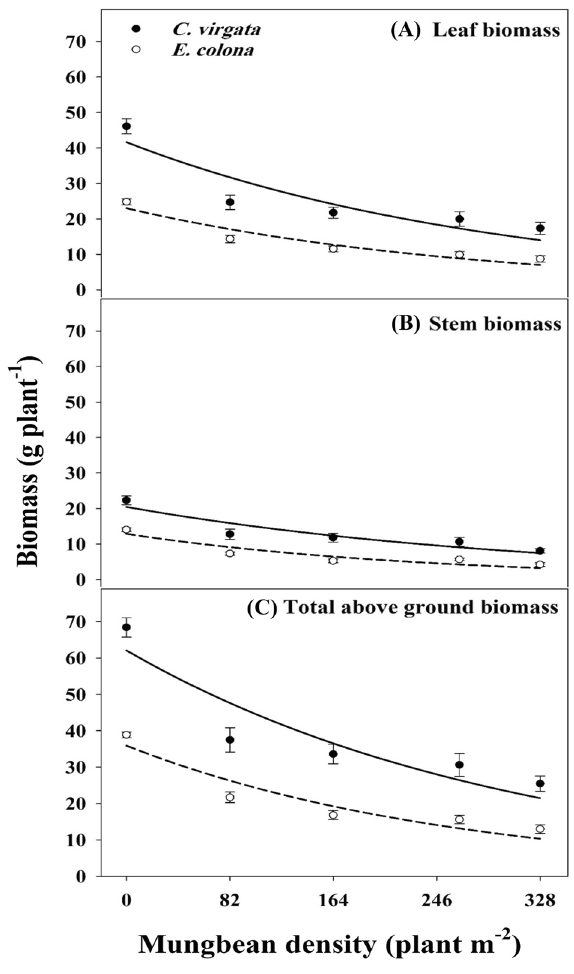
Figure 3. ( A ) Stem ( B ) leaf and ( C ) total aboveground biomass of C. virgata and E. colona when grown alone (0 MB) or in competition with 82, 164, 246 and 328 mungbean (MB) plants. The lines represent a two-parameter exponential decay model, Y = ae −bx , fit to leaf, stem, and total aboveground biomass per plant (g plant −1 ). The capped bars represent the standard error of the mean. Parameter estimates of the model are given in Table 2.